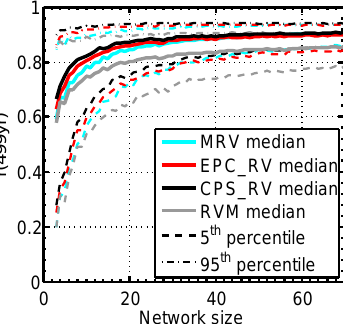
Figure 3. The 5th (lower dashed), 50th (thick) and 95th (upper dot- ted and dashed) percentiles of correlation coefficients calculated be- tween the pseudo-reconstructions of running variance and ENSO running variance ( y axis) plotted against the proxy network size ( x axis). The percentiles are calculated across the 1000 iterations of randomly selected groups of source proxies. These reconstructions are from the first series of experiments (see Sect. 3), which utilize the entire 499 years of